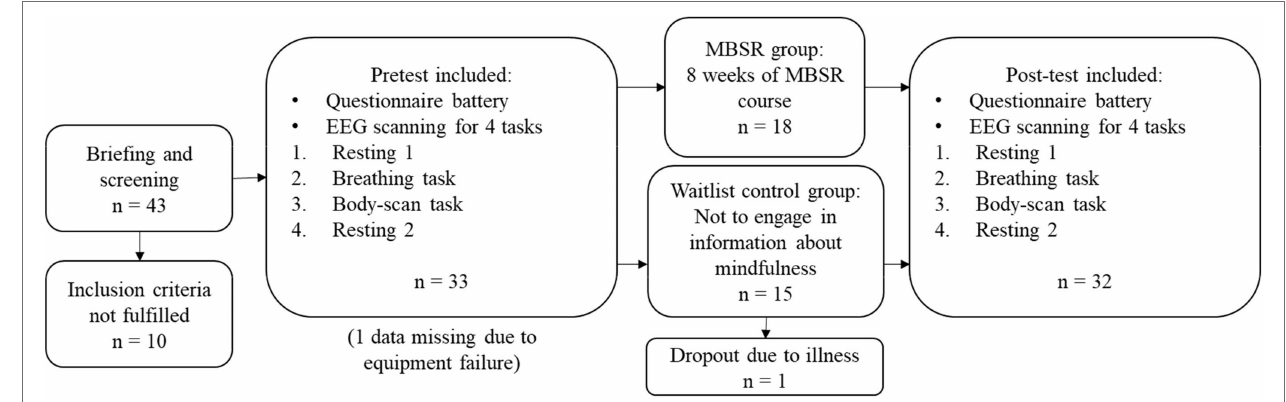
FIGURE 1 | Study design and recruitment